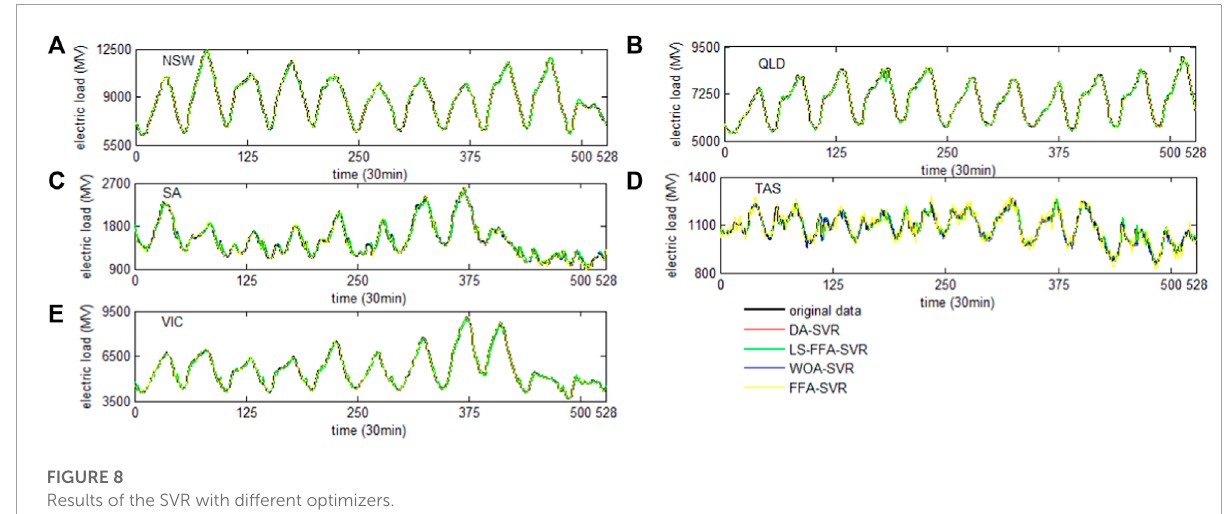
FIGURE 8 Results of the SVR with different optimizers.